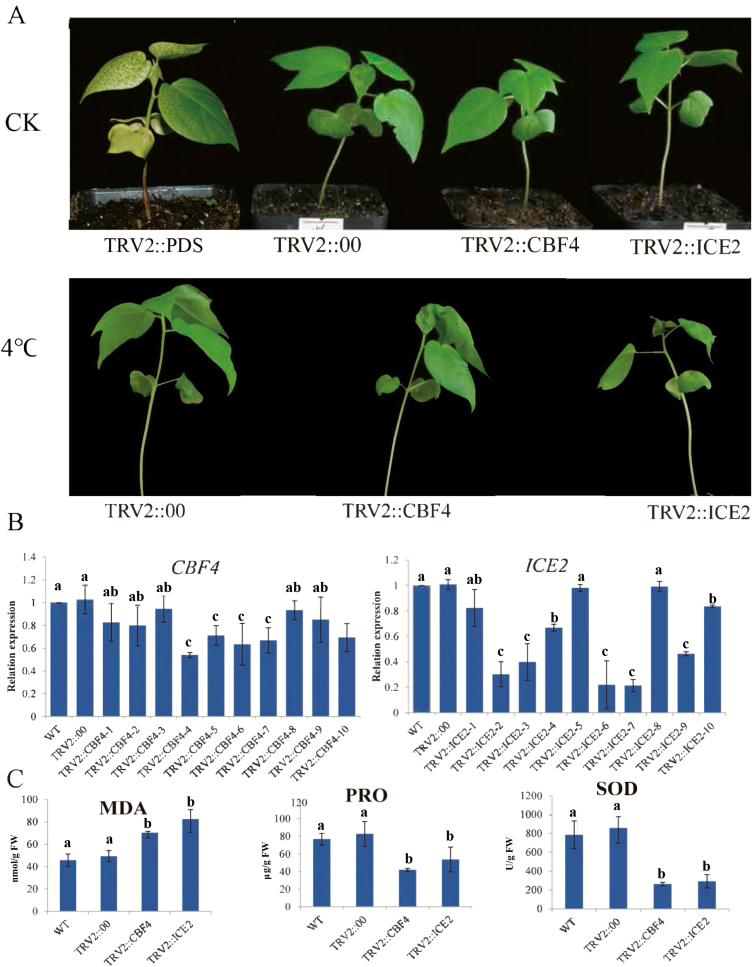
Virus-induced gene silencing (VIGS), RT-qPCR analysis and biochemical evaluation of the VIGS plants. (A) No obvious symptoms in the leaves of the TRV:00-infected plant (positive control); in each experiment, six plants were used and there were three replicates. (B) RT-qPCR analysis of the changes in the expression level of the two CBL4 and ICE2 genes in the leaf tissues of cotton plants treated with VIGS under cold stress conditions. (C) Quantitative determination of MDA, PRO and SOD in leaves of the wild type (WT), control and the silenced VIGS plants, in CBF4 and ICE2 silenced plants; line CBF4-4 and ICE2-7 were used, respectively. All measurements were done after 8 days of stress exposure. In (B) and (C), each experiment was repeated three times. Error bars of the biochemical trait measurements represent the standard deviation of three biological replicates. Different letters (a/b) indicate significant differences between WT and VIGS plants (two-tailed; P < 0.01).